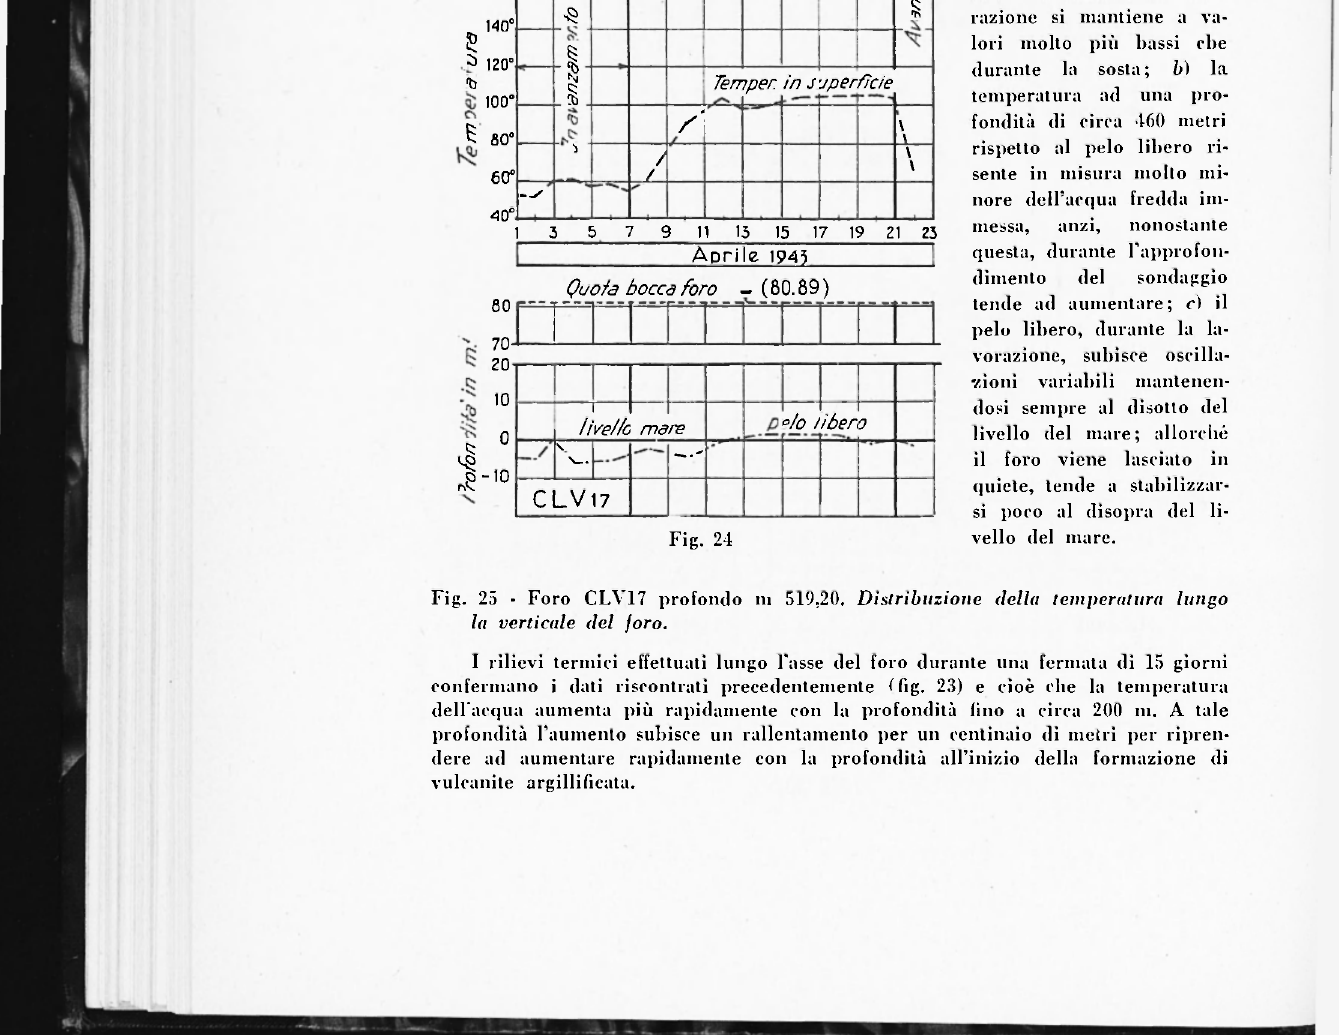
Fig. 24 - Foro C.LV17. Variazioni